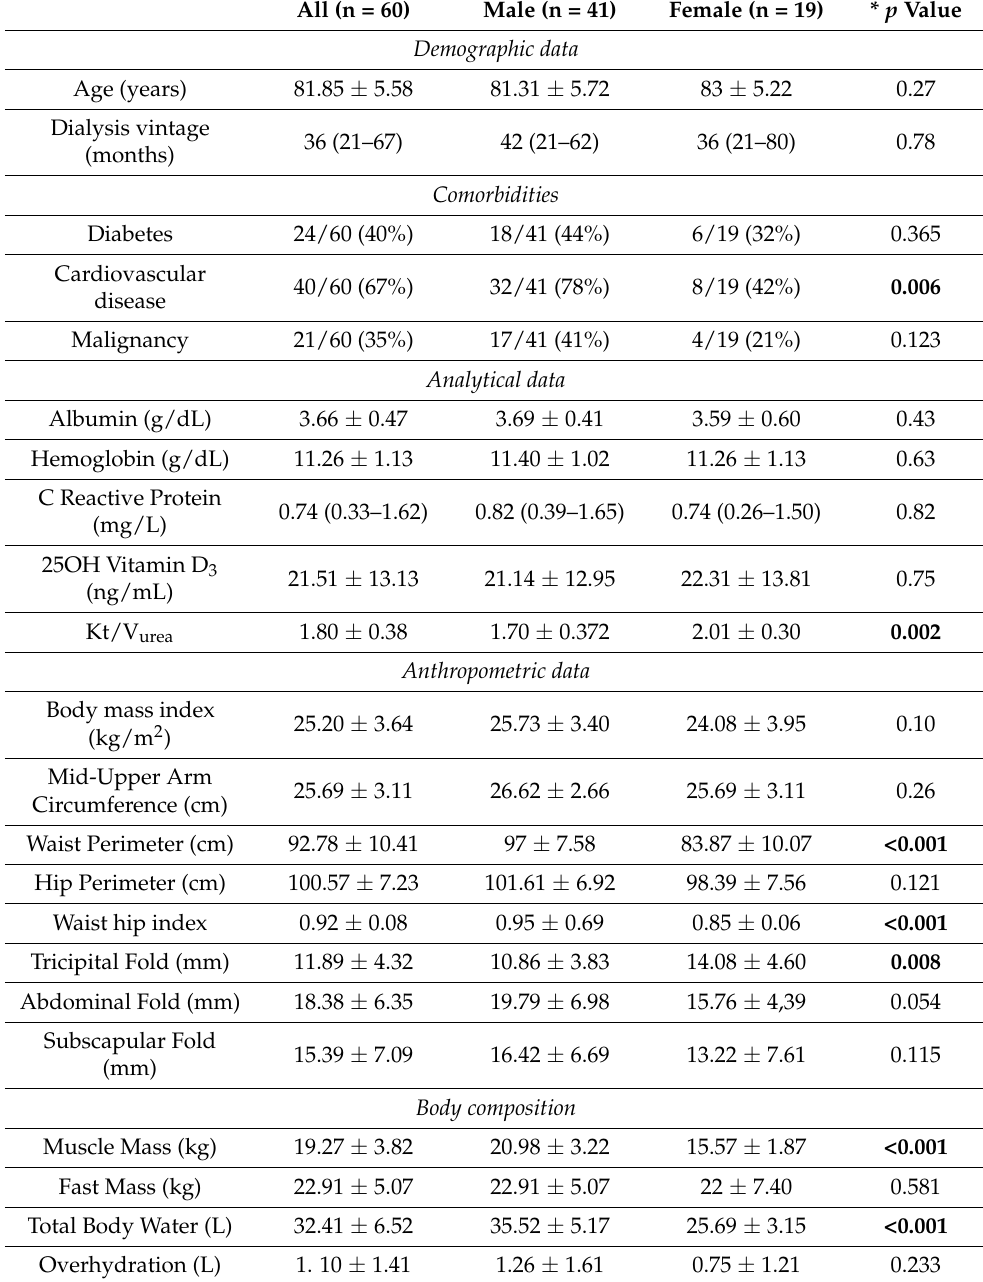
Table 2. Demographic, analytical, anthropometric and body composition (bioimpedance) data expressed as mean ± SD, median (interquartile range) or n